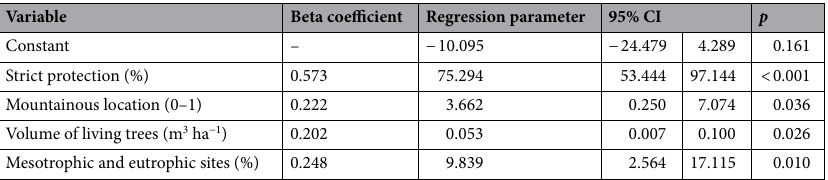
Table 2. Linear regression results for deadwood volume.